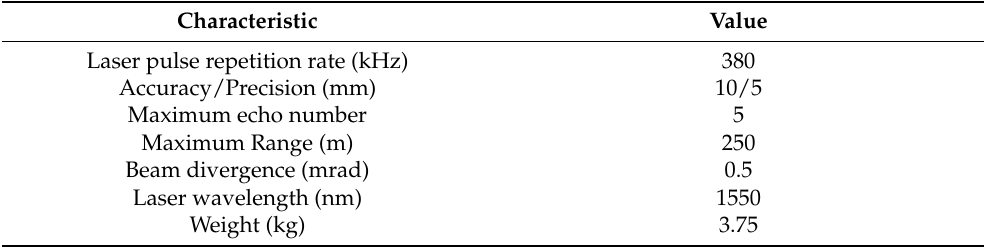
Table 1. Descriptive statistics of the operational parameters for the UAVLS data collection.